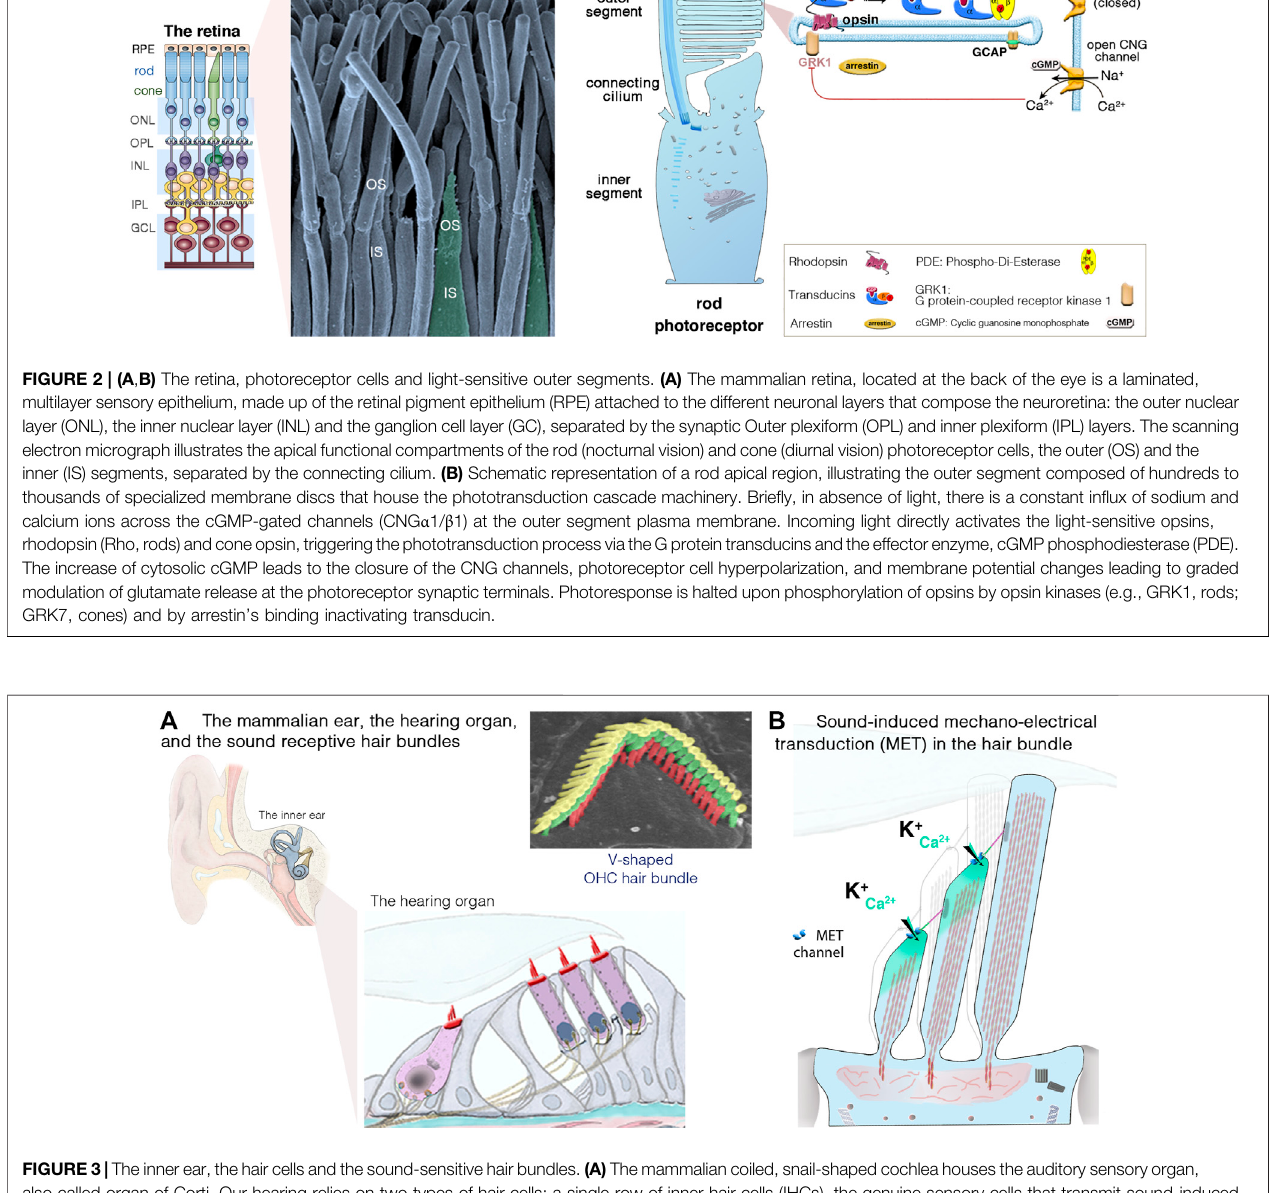
Frontiers in Genome Editing |